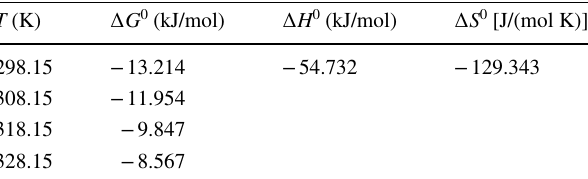
Fig. 14 Adsorption thermodynamic fitting diagram Table 5 Adsorption thermodynamic data